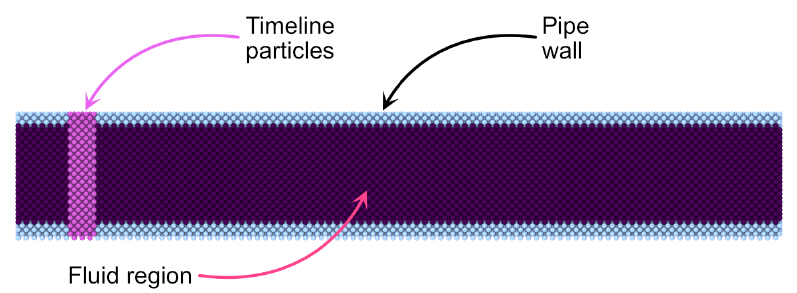
Figure 21. Tracking particles for construction of timelines in pipe